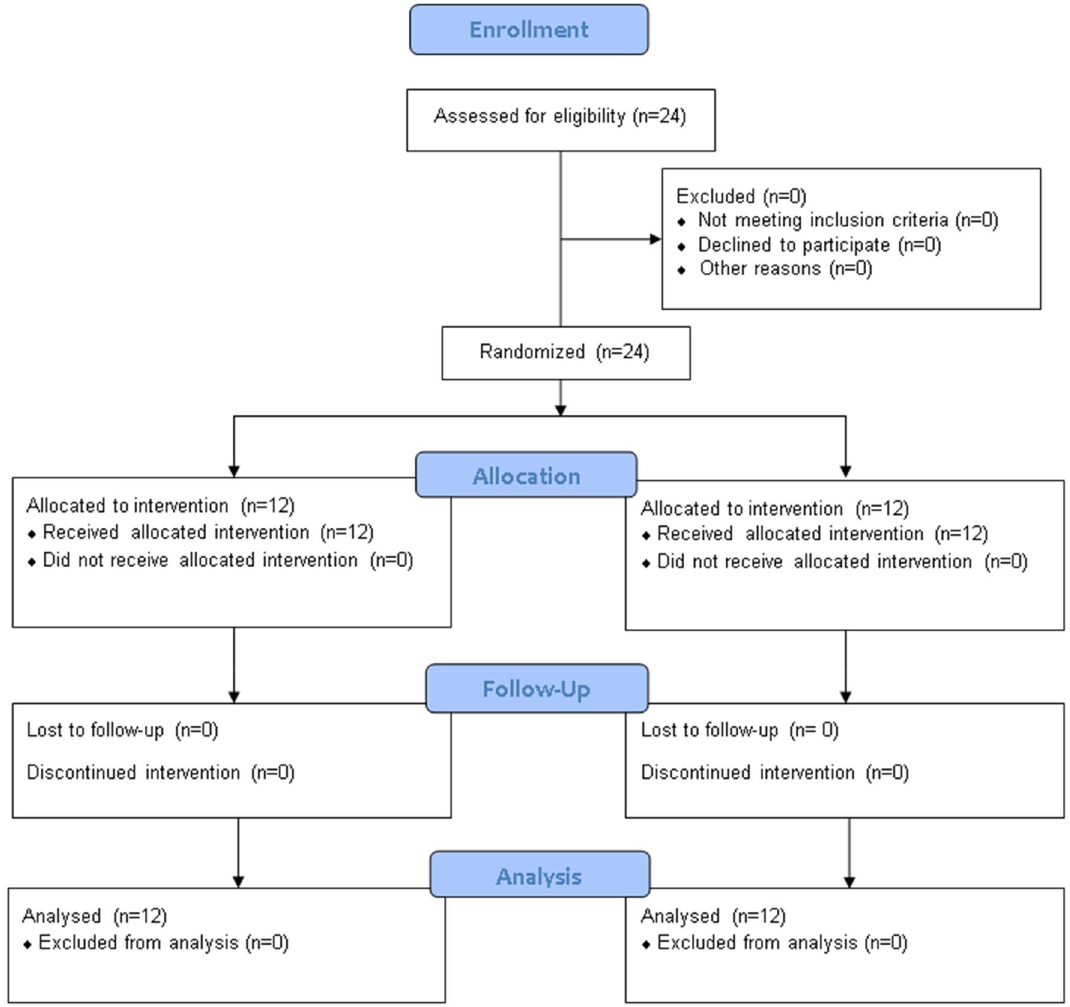
Figure 1. Consolidated Standards of Reporting Trials (CONSORT) flow chart of the